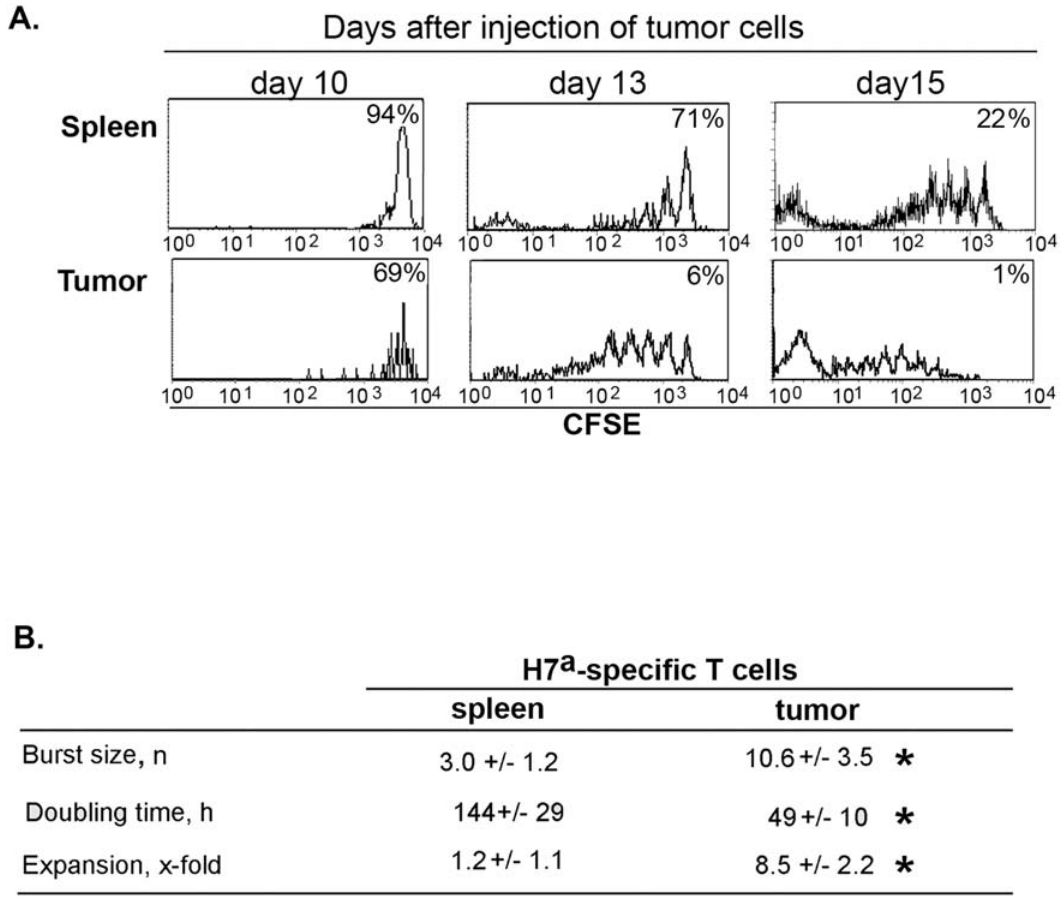
Figure 3. Evaluation of T-cell proliferative dynamics from CFSE profiles. B10 recipient were treated as in Fig. 1. A) One representative example of the CFSE profiles observed at each time point (gated on CD8 + H7 a tetramer + T cells) in the spleen and tumor. Numbers in the upper right corner of each panel represent the percentage of undivided cells (that is, cells showing the highest levels of CFSE). B) Mean ( 6 SD) burst size, doubling time and expansion of H7 a -specific T cells between day 10 and day 15 in the spleen and tumor. The proliferative burst size and doubling time of anti- H7 a T cells were calculated as described in materials and methods. Expansion corresponds to the mean number of cells on day 15/mean number of cells on day 10. Each group contained 3–5 mice. * P , 0.001 (spleen vs. tumor).